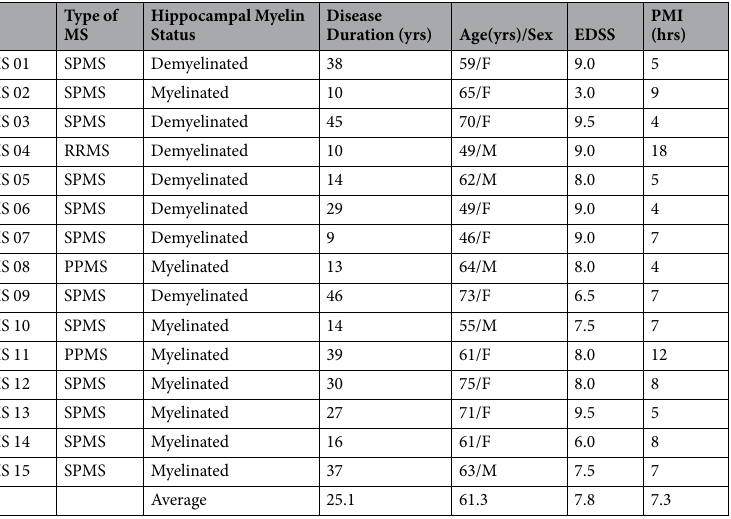
Table 1. Demographics of MS patients. SPMS: Secondary Progressive Multiple Sclerosis; PPMS: Primary Progressive Multiple Sclerosis; RRMS: Relapsing Remitting Multiple Sclerosis. EDSS: Expanded Disability Status Scale; PMI: Postmortem